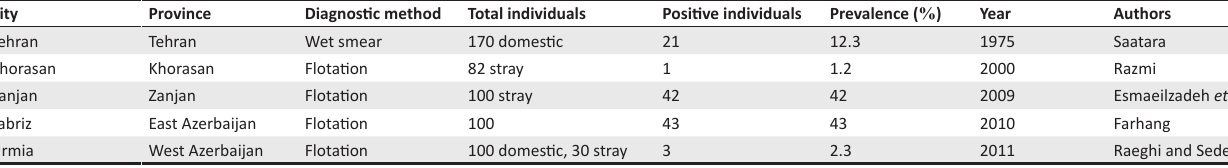
TABLE 2: Studies of cat toxoplasmosis included for meta-analysis based on stool examination.